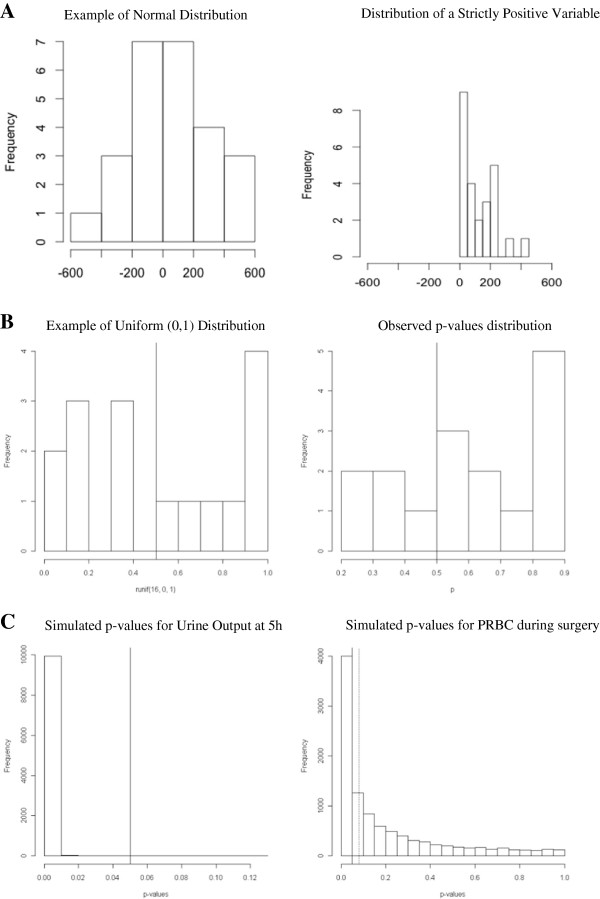
Illustration of the checking procedure. A Variable distribution. The variable FFP during surgery is described with a mean of 60 and a SD of 210. As shown in the left panel, if this variable was normally distributed, it should exhibit some negative values. Because negative values are impossible for such a variable, its distribution is necessarily asymmetric (right panel: example of a strictly positive variable characterized by a large SD). BP value distribution under the null hypothesis. Left panel represents the theoretical distribution of the p values under the null hypothesis, that is a uniform (0,1) distribution: p values are equally distributed on both sides of the middle line. As shown in the right panel, the observed p values are likely not to be distributed uniformly. C Distribution of the simulated p values corresponding to the comparison of two variables in the two groups across the 10,000 simulated datasets. The left panel shows a very high probability for the comparison of the urine output at 5 hours to be statistically significant, whereas it was reported as nonsignificant by the authors. The left panel shows the distribution of the simulated p values concerning the comparison of the PRBC during surgery: the black vertical line represents the 0.05 threshold of statistical significance, and the dashed line represents the p value that has been explicitly computed, given the observed mean and SD in the two groups.